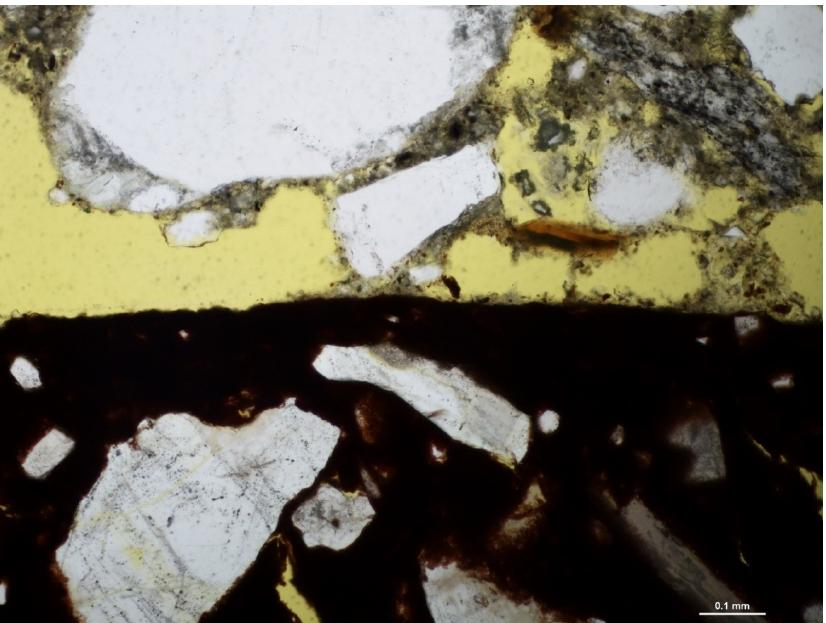
Figure 7. Microscopy image of a thin section; an area with large, elongated air voids. The yellow parts are air voids, whilst the white parts are aggregate, and the contact zone is the interface between the dark and the charcoal-coloured cement paste.